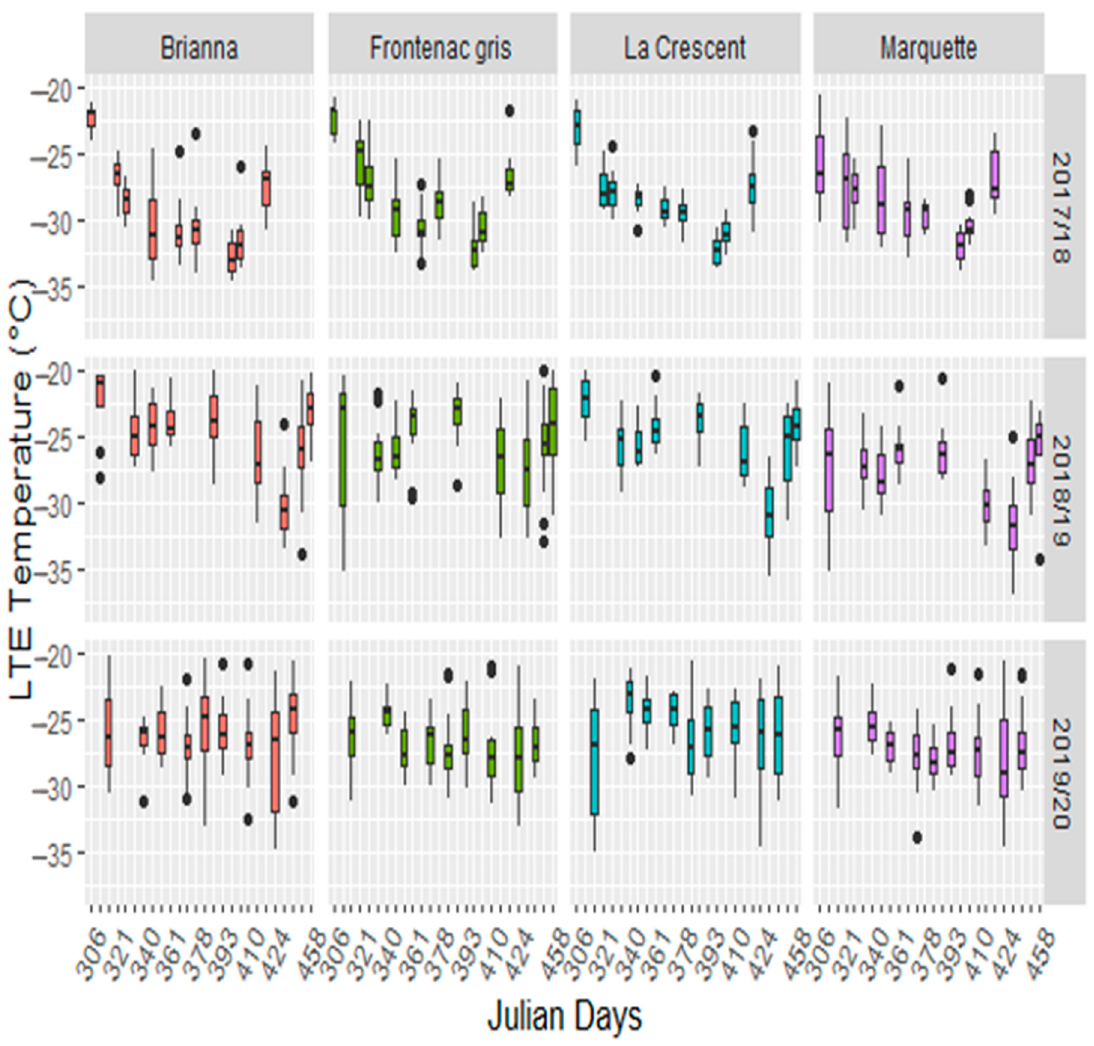
Figure 2. Low temperature exotherms for Brianna, Frontenac gris, La Crescent, and Marquette across the 2017/18, 2018/19 and 2019/20 dormant seasons.